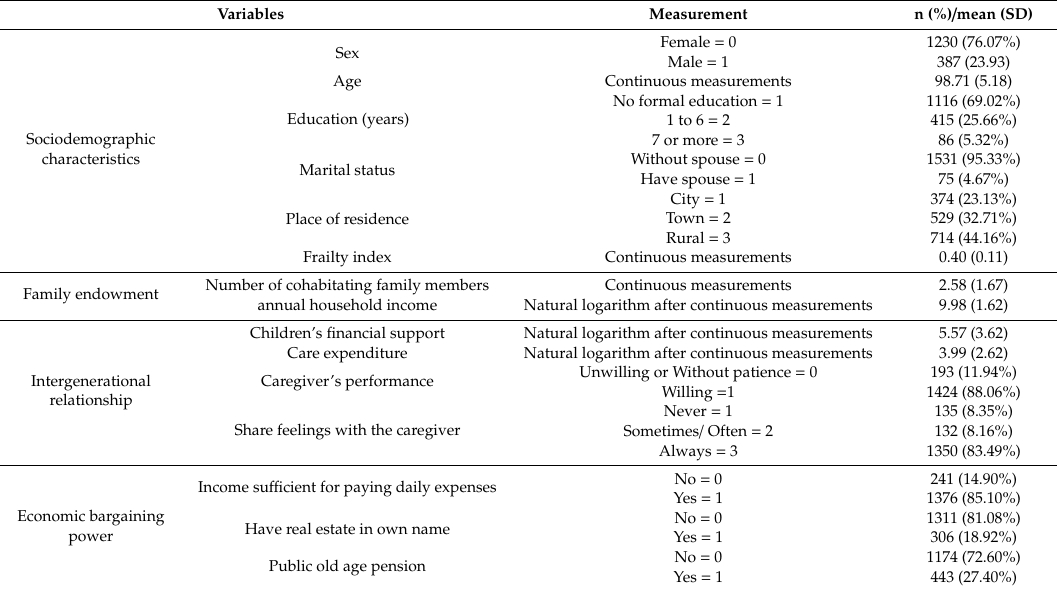
Table 1. Descriptive statistics of the study